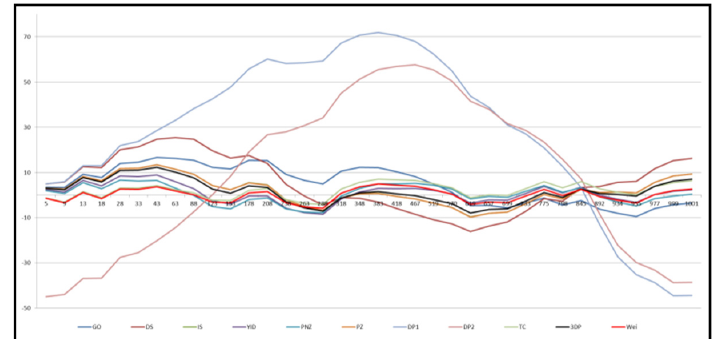
Figure 2. Relative error value of 11 models in Table 1 for Dataset #1.